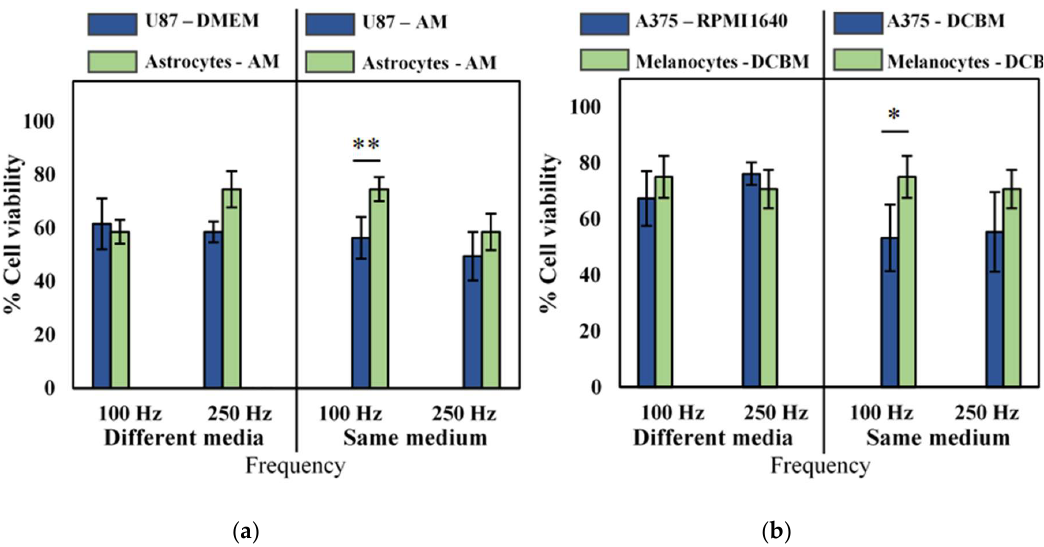
Figure 4. Analysis of selectivity with the direct treatment for brain cancer and skin cancer. A 10 second treatment with a gap of 1 mm and a frequency of either 100 Hz or 250 Hz was used to treat ( a ) brain and ( b ) skin cancer and non-cancerous cells. Data are represented as mean ± standard deviation (SD) of three independent experiments with at least two replicates. Statistical significance of all treatment conditions was compared to untreated. * p < 0.05, ** p < 0.01, and *** p < 0.005 (one-way ANOVA).